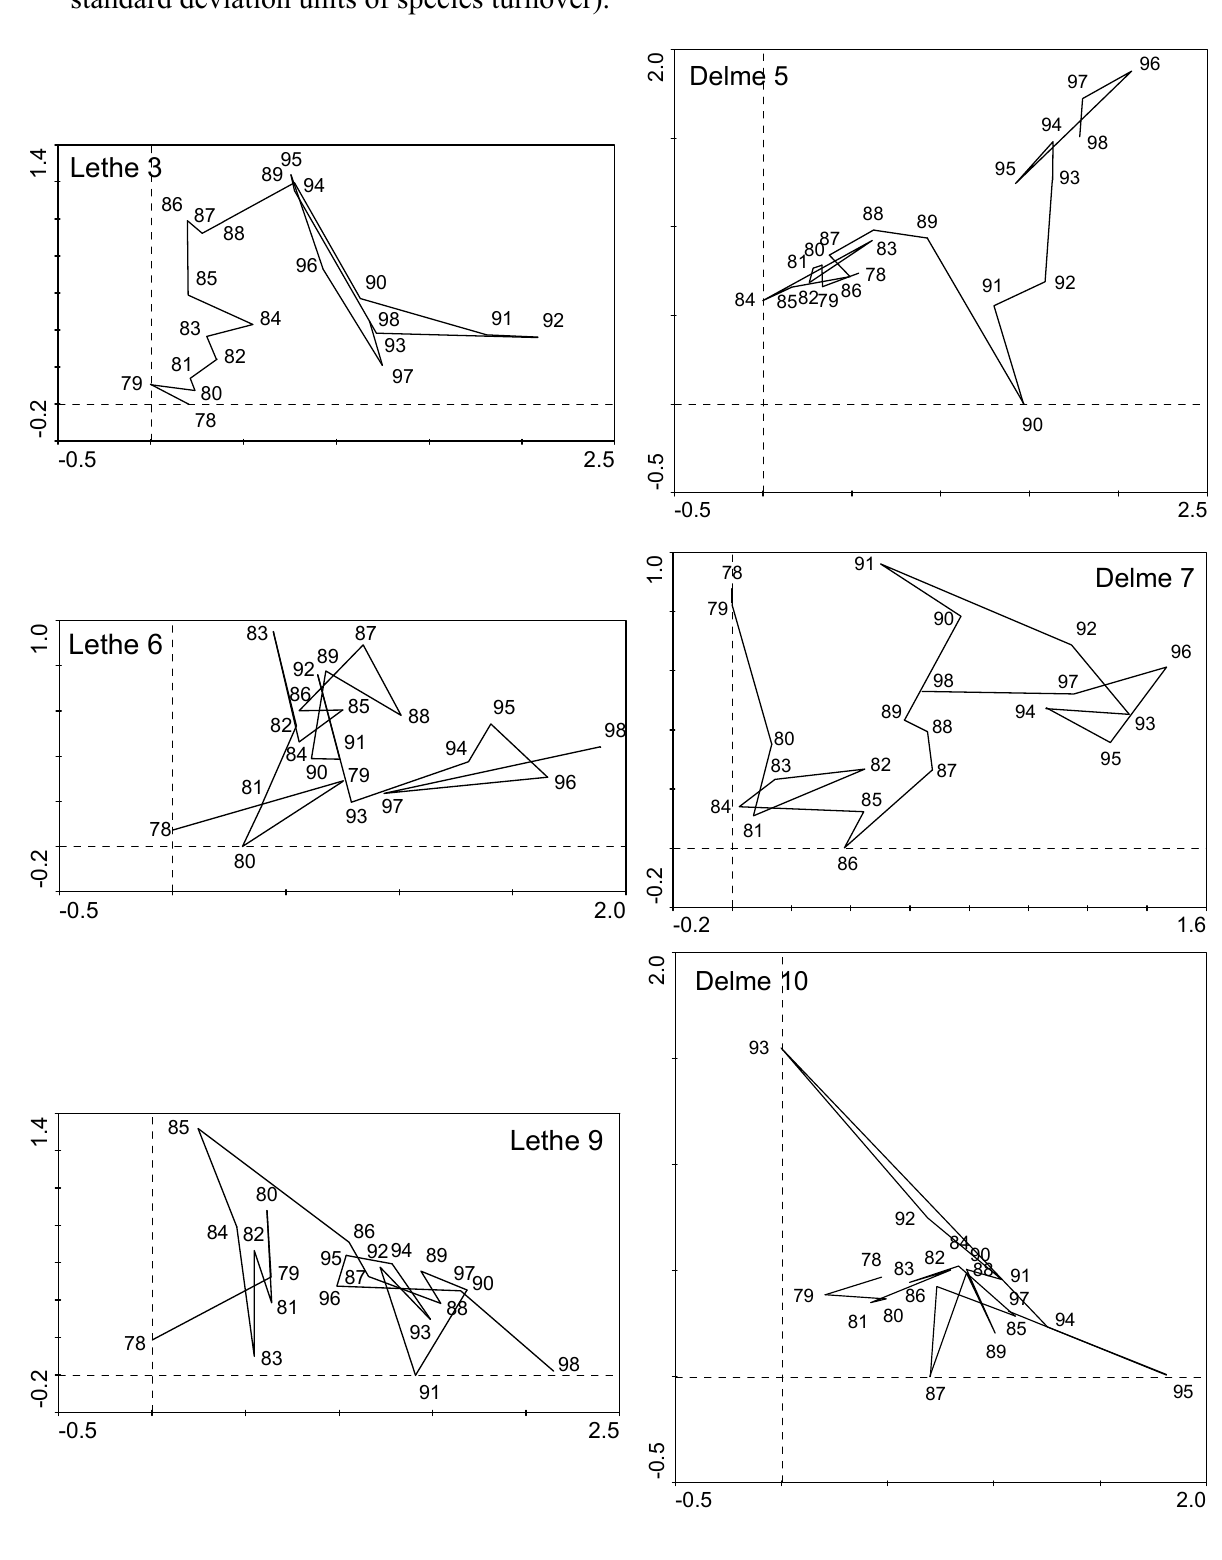
Figure 7. Temporal variation of year of sampling of the six sites surveyed in the rivers Lethe and Delme (Lower Saxony, Germany) based on changes in hydrophyte species composition along two independent axes of Detrended Correspondence Analyses (units are standard deviation units of species